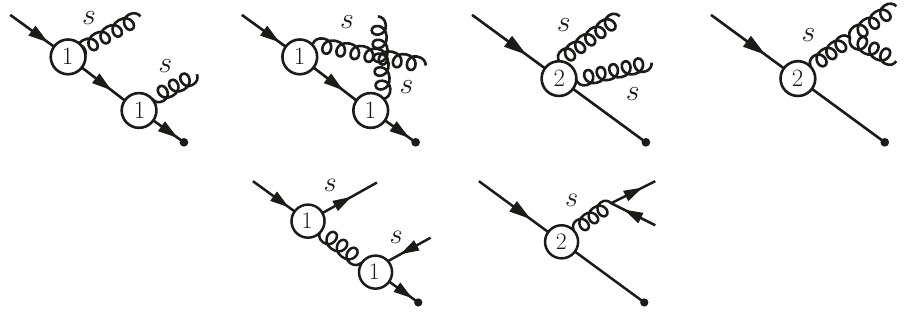
Figure 5 . Diagrams contributing to the matching of the two soft parton collinear functions. Soft lines are labelled with an \s". The contributions from the one-soft-particle reducible diagrams, when the internal gluon originates from n + terms in the equation of motion relation (2.26) applied to